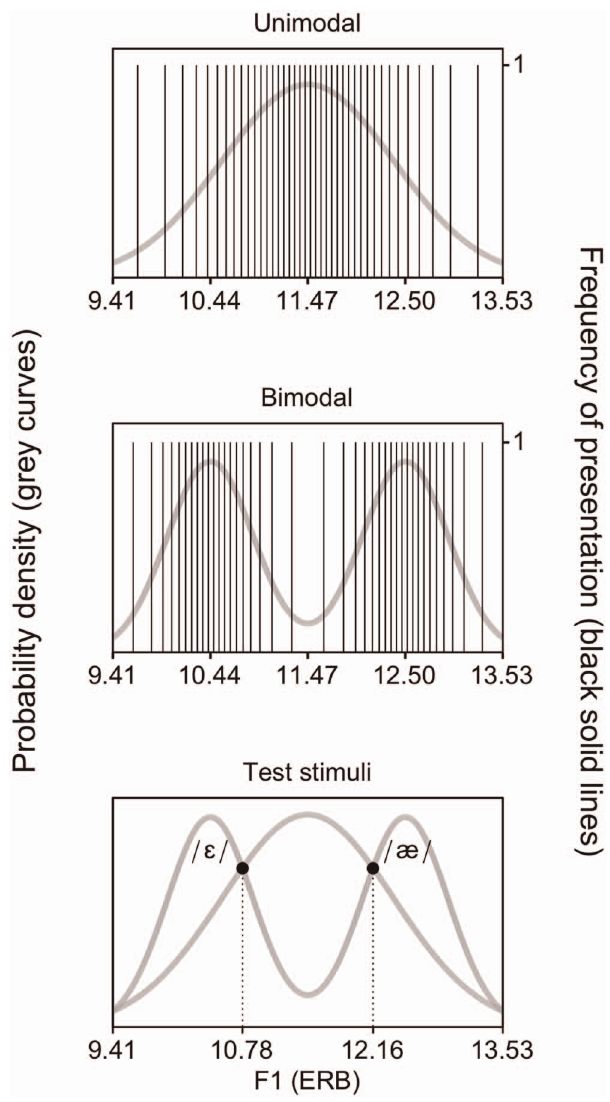
Figure 1. Distributions of first formant (F1) values (in ERB). The unimodal (top) and bimodal (middle) distributions represent the Dutch vowel / e / and the English vowel contrast / e / , /æ/, respectively. Each solid vertical line indicates a vowel token with a specific F1 value. Each vowel token was presented only once (i.e., the height of the vertical lines is 1). The grey curves are the underlying probability density functions. When creating training distributions, the acoustic values of the test stimuli can be calculated by computing the intersections (black discs, bottom) of the unimodal and bimodal distributions.